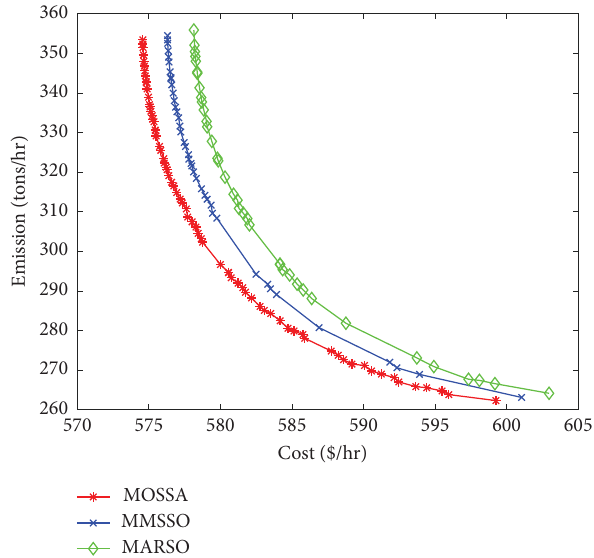
Figure 10: Comparison of pareto-optimal fronts obtained by MOSSA, MMSSO, and MARSO for strategy B 3 1 .